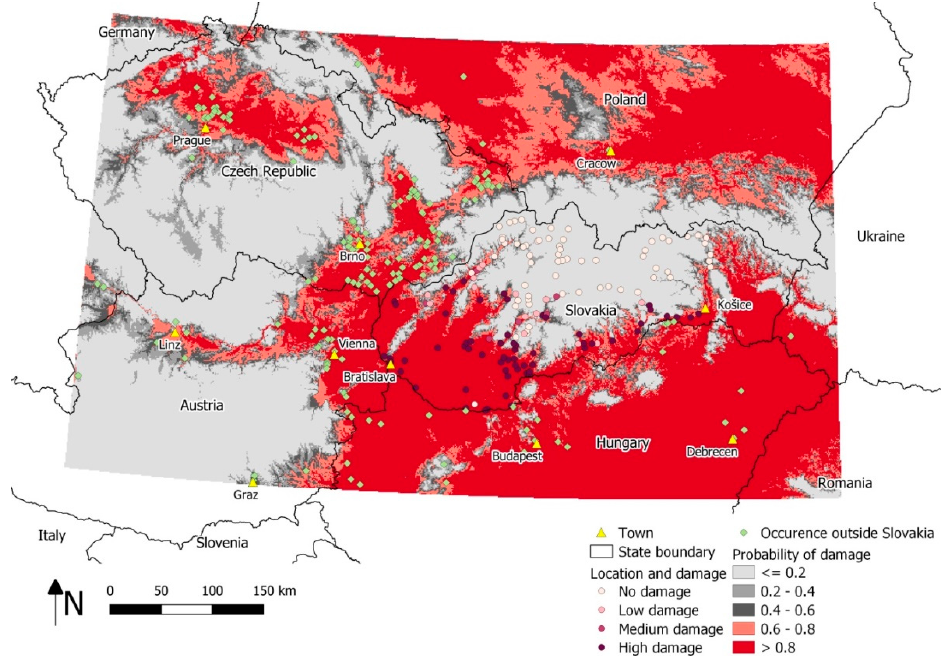
Figure 5. Map of Slovakia and surrounding regions showing the probability of any damage to box trees by Cydalima perspectalis predicted by altitude. Locations and damage to box trees in Slovakia—original (own) data; occurrence outside Slovakia—data from the literature.